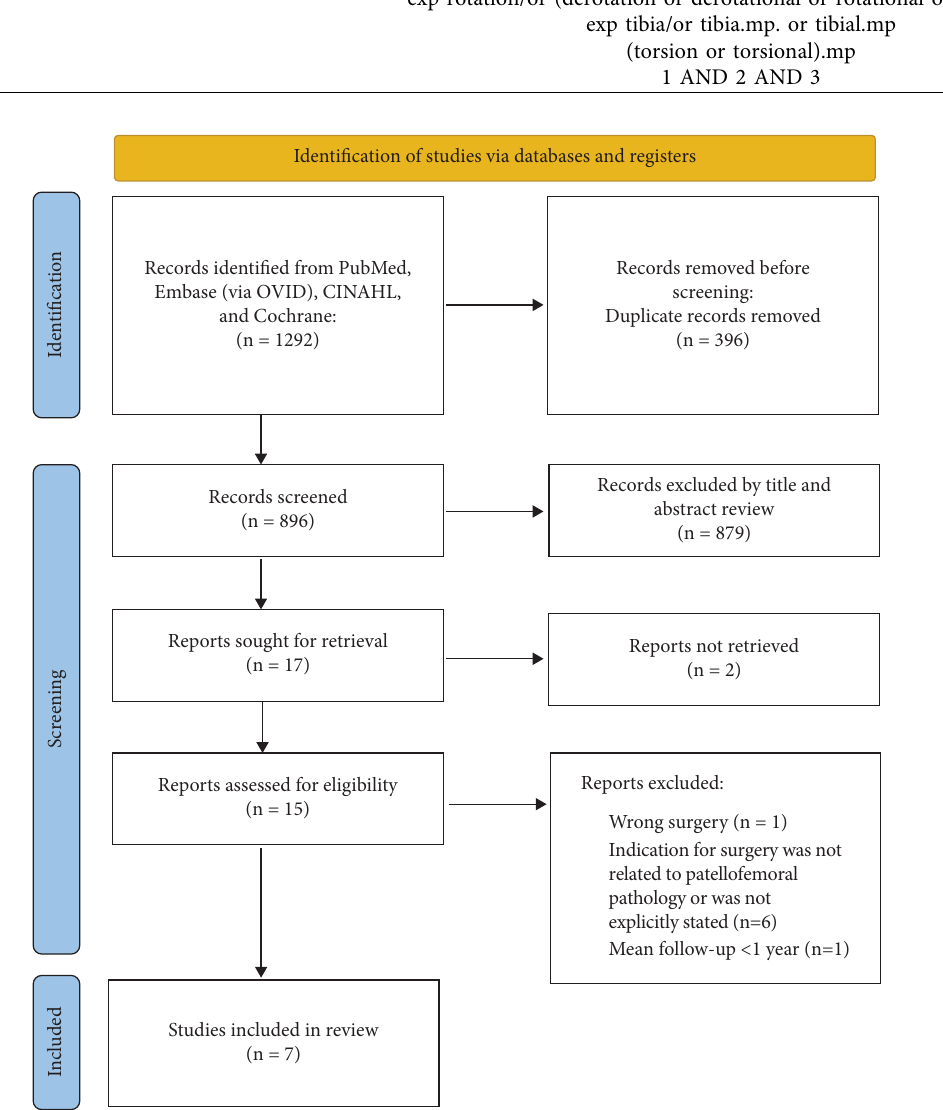
Figure 1: PRISMA 2020 fow diagram depicting the exclusion/inclusion process.